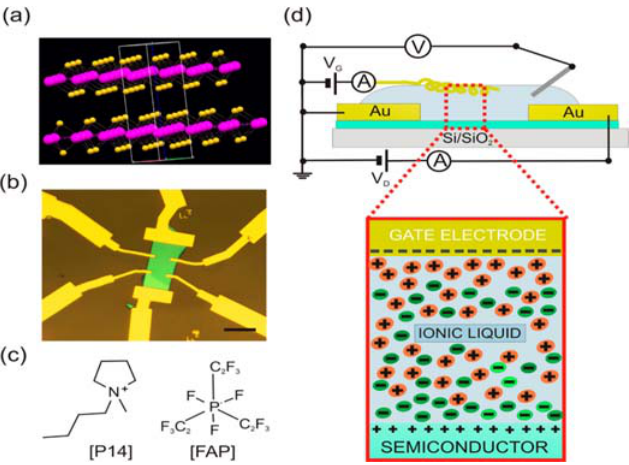
Figure 13. ( a ) Crystal structure of layered WS 2 ; the purple balls correspond to W atoms and the yellow balls to S atoms. ( b ) Optical microscope image of a six-terminal Hall bar fabricated on a crystalline WS 2 thin flake (the scale bar is 10 μ m long). ( c ) Molecular structure of the ionic liquid employed as an electrolyte–gate dielectric. Both cation [P14] + and anion [FAP] − are shown. ( d ) Cross-section of a WS 2 ionic liquid-gated FET. A large area of gold mesh and an oxidized Ag/AgO wire are used as a gate electrode and quasi-reference electrode, respectively. When the gate electrode is biased, two electrical double layers are formed at the gate/electrolyte and semiconductor/electrolyte interfaces, enabling charge accumulation at the semiconductor surface. Reprinted with permission from ref. [85]. 2012 American Chemistry Society.